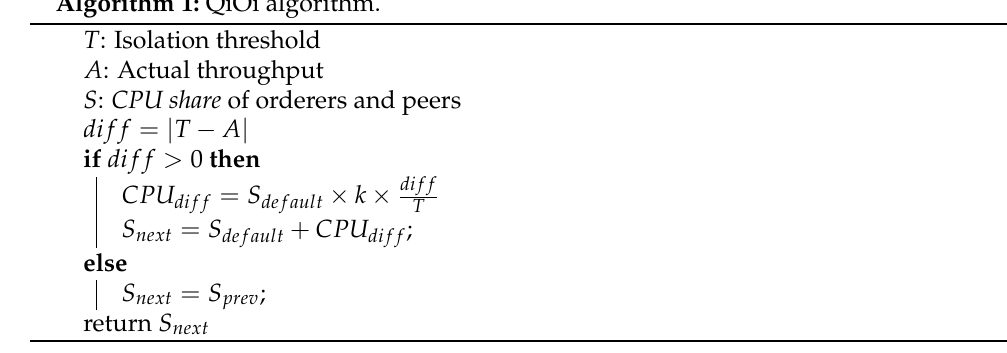
Algorithm 1: QiOi